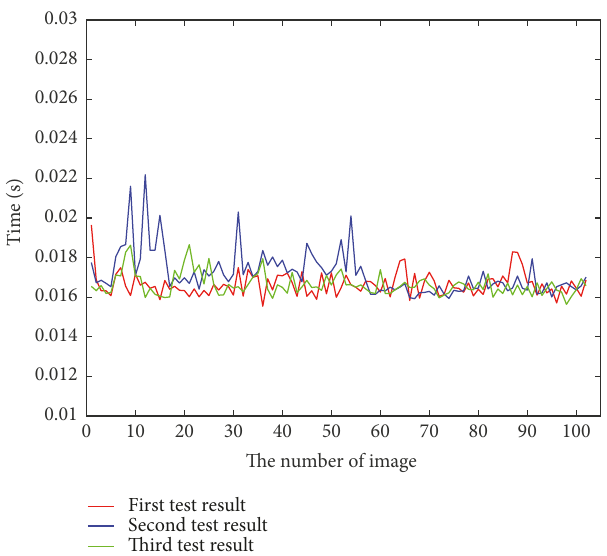
Figure 10: The test results of background update efficiency.